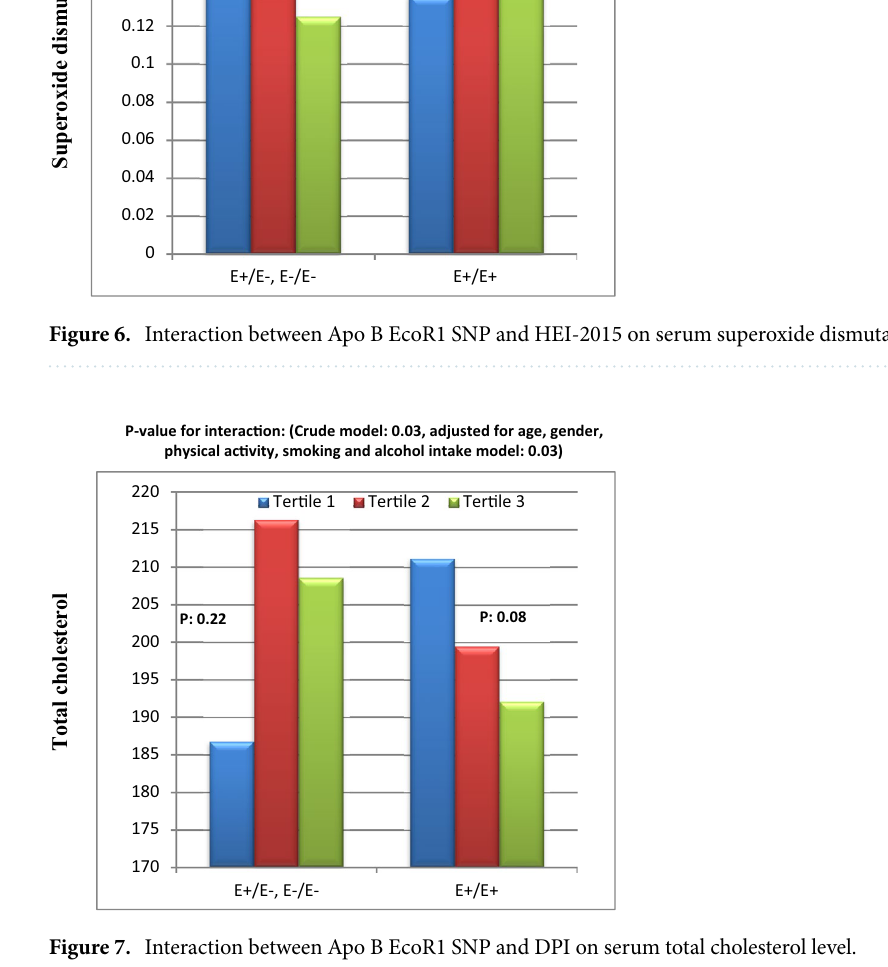
Figure 7. Interaction between Apo B EcoR1 SNP and DPI on serum total cholesterol